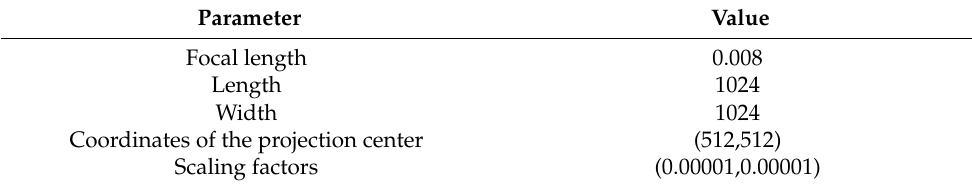
Table 1. Simulation Parameters of the